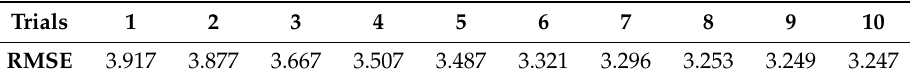
Table 3. RMSE results of 10 trials for a model with three stacked hidden layers.